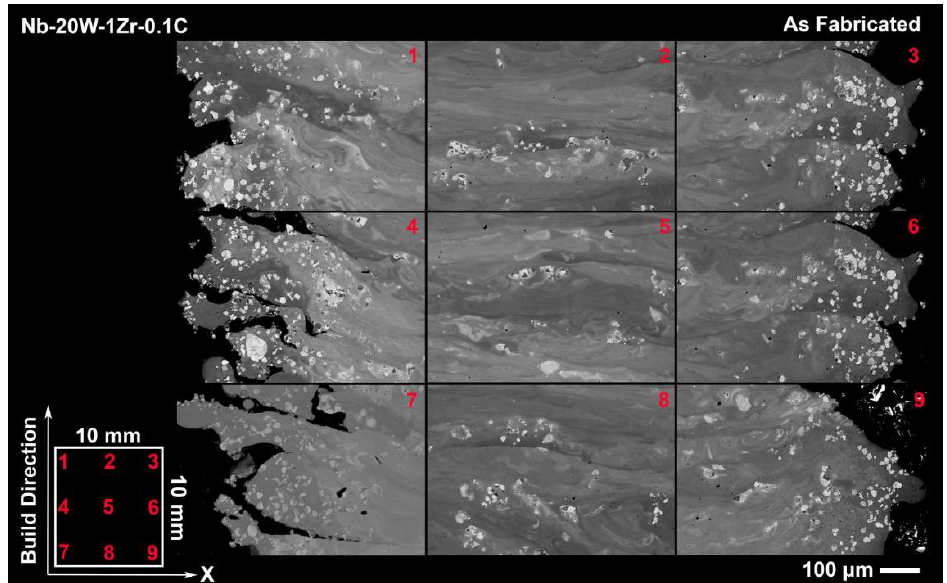
Figure 8. Tiled backscatter SEM image of as fabricated Nb-20W-1Zr-0.1C tensile sample witness cylinders depicting spatial microstructural variations.